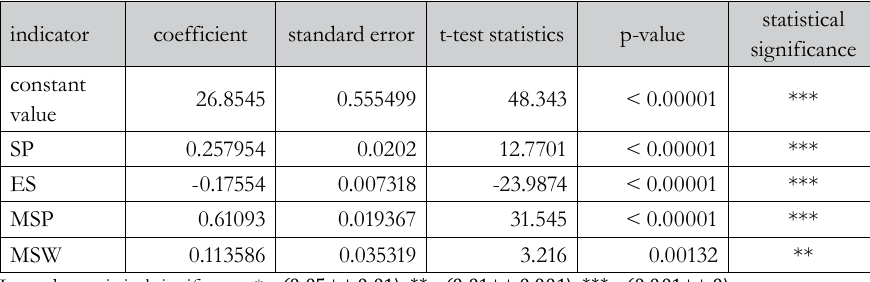
Tab. 1 – Summary of the first regression model. Source: own elaboration